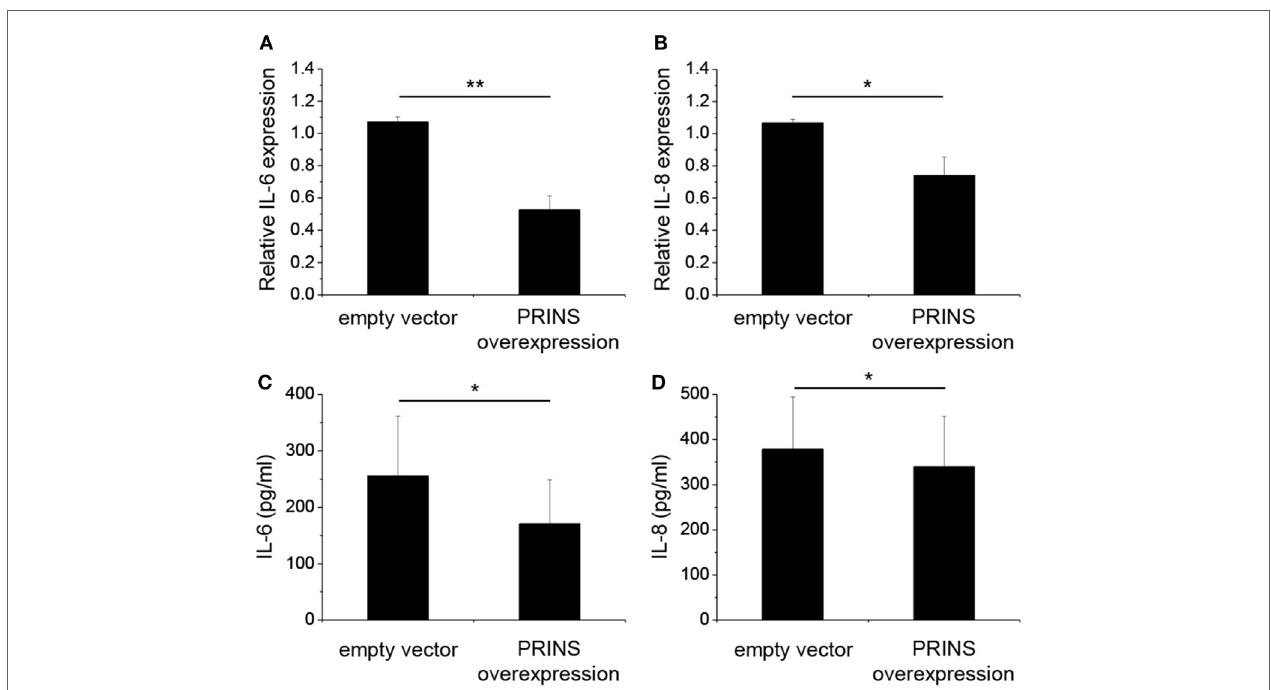
FigUre 3 | Overexpression of PRINS regulates the expression and secretion of interleukin-6 (IL-6) and IL-8. In parallel to priming with 5 ng/ml tumor necrosis factor- α and interferon- γ , normal human epidermal keratinocytes were transfected with a pcDNA3.1( + ) vector containing the PRINS cDNA; an empty pcDNA3.1( + ) vector was used as control. After 24 h, cells were transfected with poly(dA:dT). RNA expression of cytokines IL-6 (a) and IL-8 (B) was detected by real-time RT-PCR. Secretion of cytokines IL-6 (c) and IL-8 (D) , was detected by ELISA from cell supernatants. Data are presented as mean ± SE of four independent experiments (* p ≤ 0.05; ** p ≤